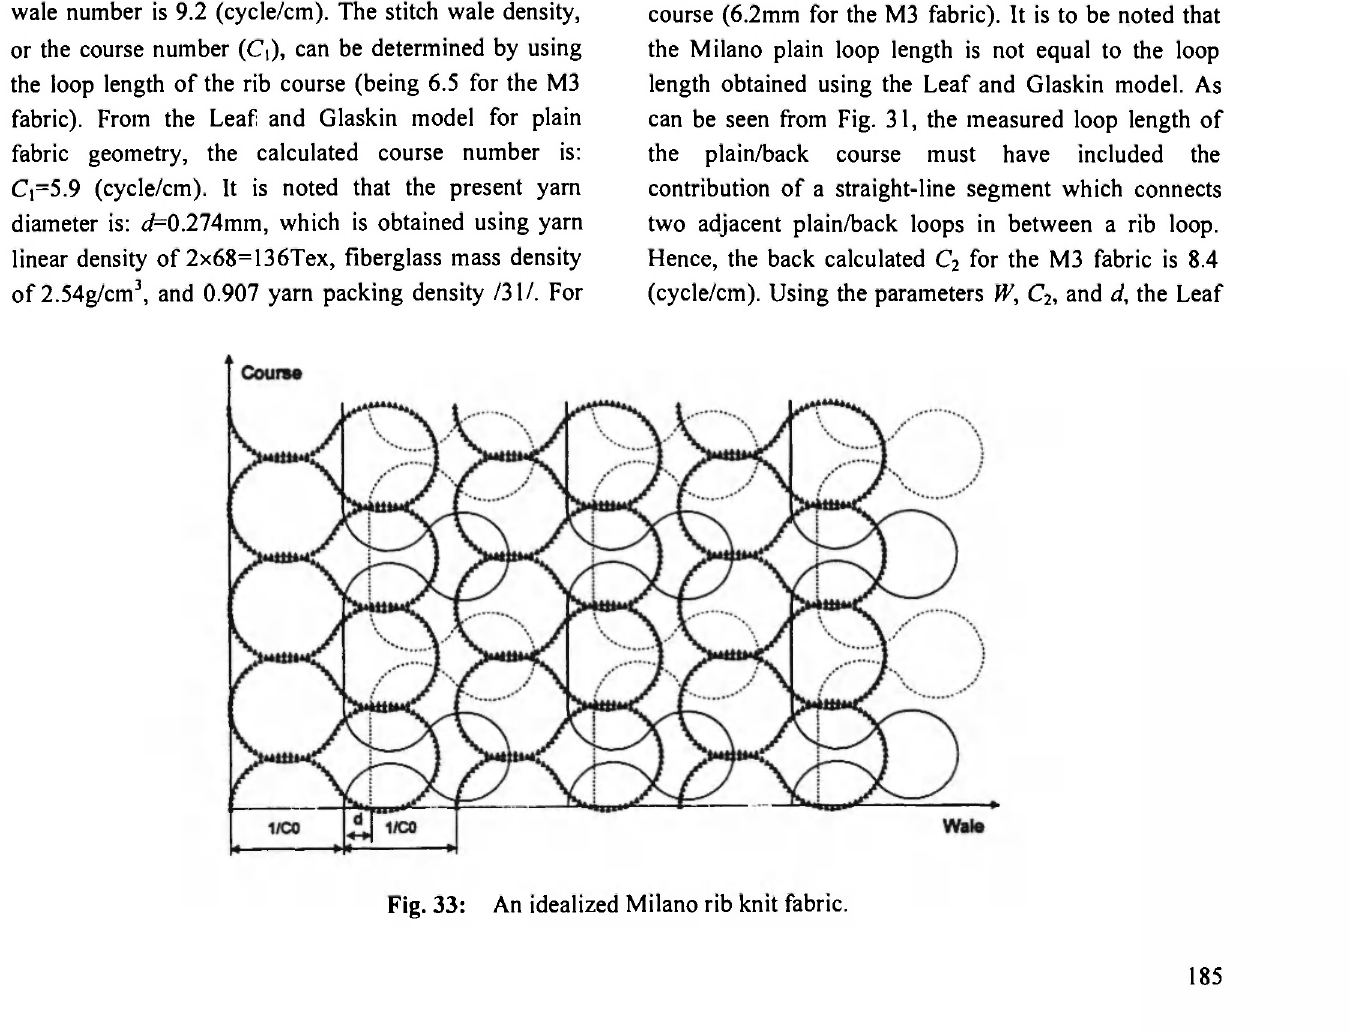
An idealized Milano rib knit